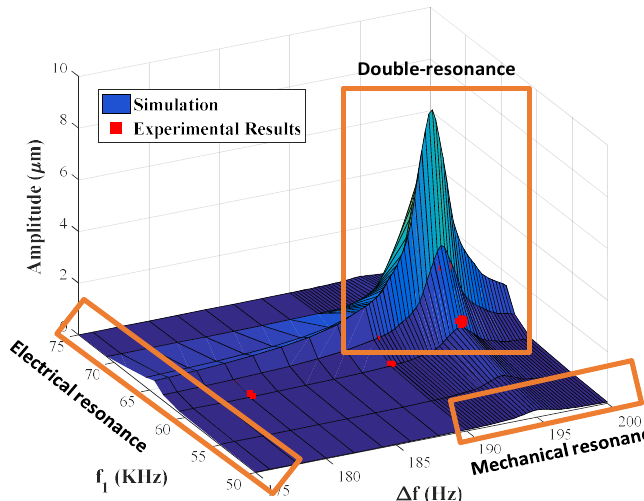
Figure 7. Three-dimensional plot of the simulated frequency response as a function of the excitation frequencies f 1 and ( f 2 = f 1 + ∆ f ). The voltage of each signal component is V 1 = V 2 = 1 V. The experimentally obtained points are in red.